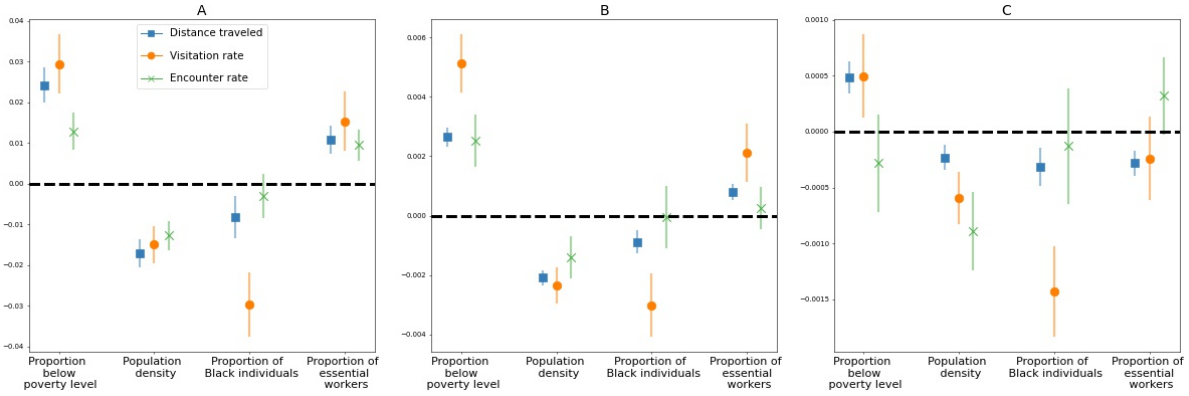
Figure 3. Regression coefficients of distance traveled, visitation rate, and encounter rate for the 4 socioeconomic factors associated with social distancing: (A) mobility during social distancing (phase 3); (B) decline in mobility during entry to the social distancing phase (phase 2); and (C) resurgence in mobility during exit from the social distancing phase (phase 4). The marker denotes the mean coefficient, and the error bars show the 95% confidence interval. A positive association (above the dashed line) indicates that an increase in a given factor leads to a weaker implementation of social distancing. A negative association (below the dashed line) indicates that an increase in the given factor is associated with a stronger implementation of social distancing